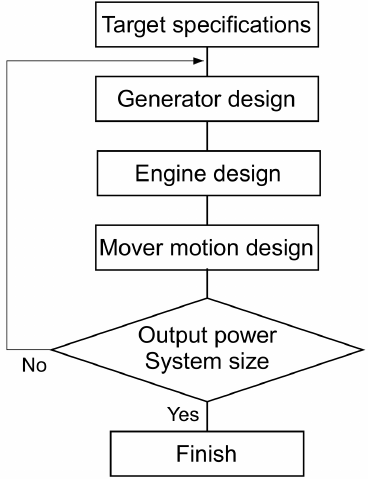
Figure 9. FPEG construction procedure II (for